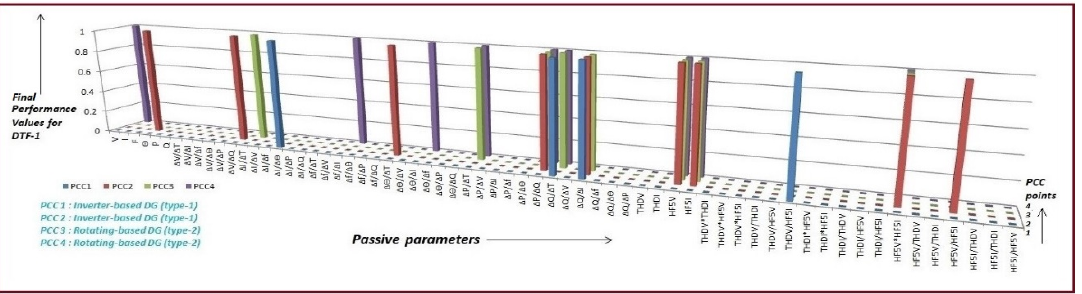
Figure 6. Effective passive parameters for DTF-1 (IEEE 13 bus system) for the LPM range of PCCs 1 to 4.